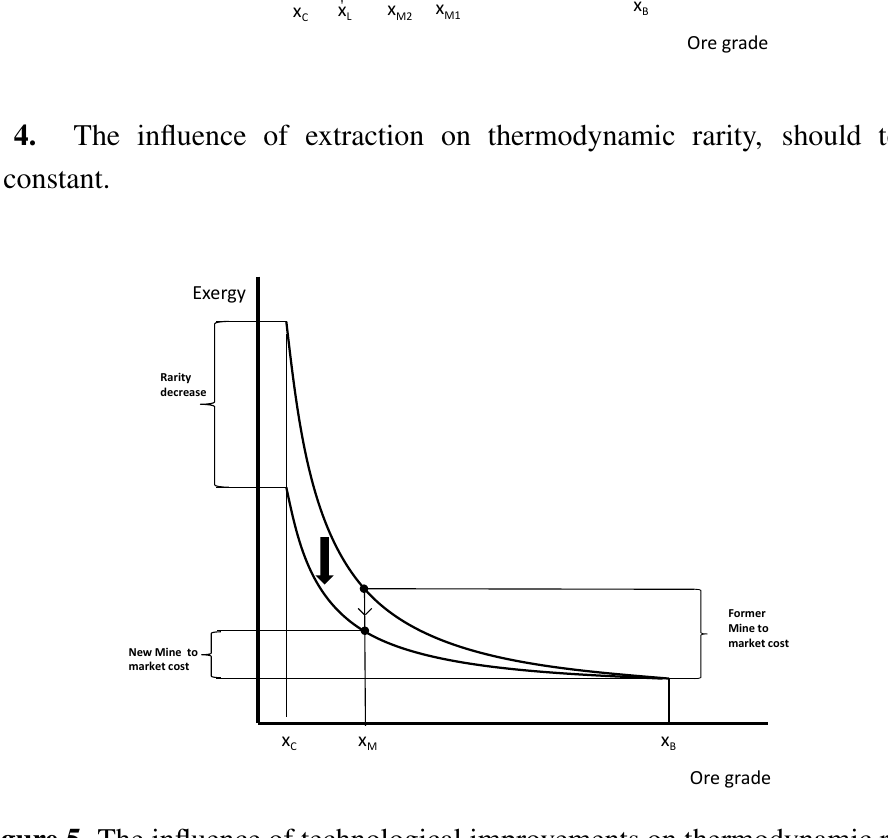
Figure 5. The influence of technological improvements on thermodynamic